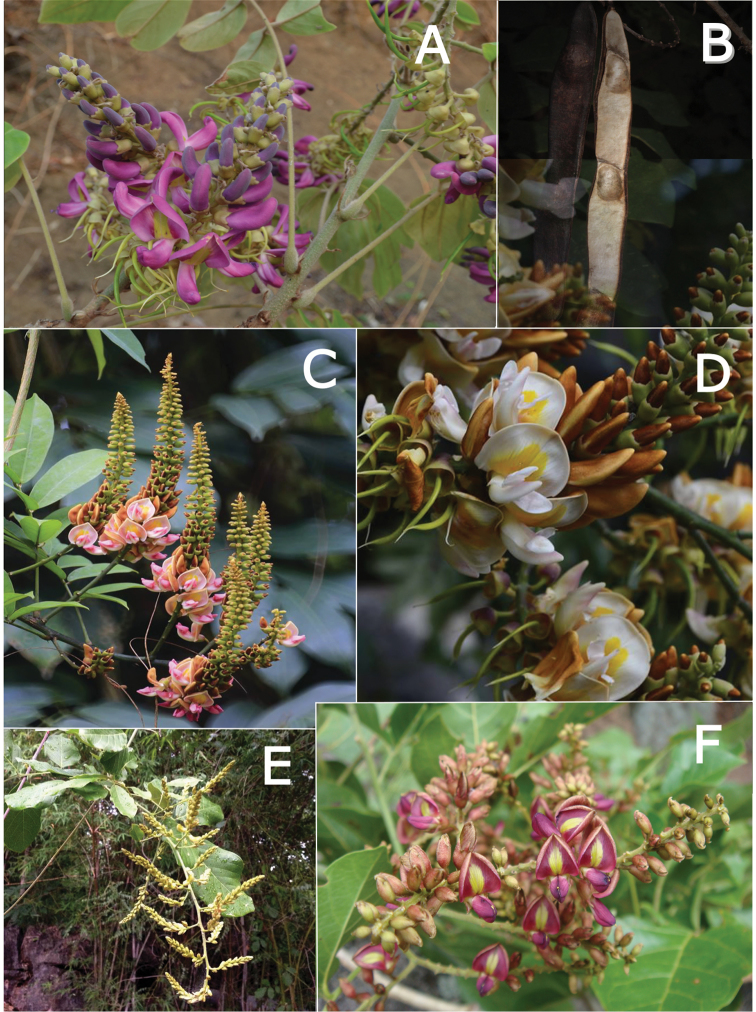
Endosamara, Sigmoidala and Kanburia. A, BEndosamararacemosa, Thailand, Sakon Nakhon Prov., S.Mattapha s.n.. C, DSigmoidalakityana Thailand, Nan Prov. S.Mattapha 1117EKanburiachlorantha Thailand, Kanchanaburi Prov. Y.Sirichamorn Y2014-15-1FKanburiatenasserimensis Thailand, Ratchaburi, Khao Chon waterfall Y.Sirichamorn YS2015-8.